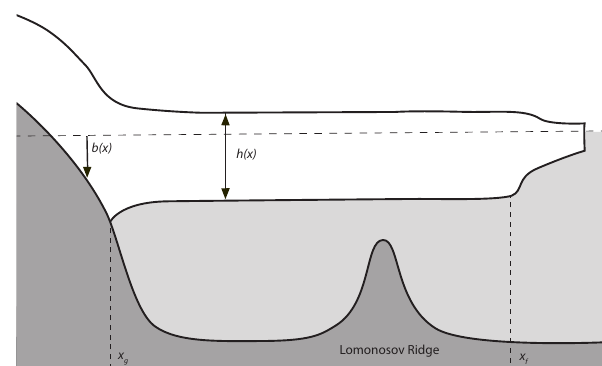
Figure 3. The geometry of the one-dimensional Arctic ice-sheet– ice-shelf model, illustrated in a case without grounding on the Lomonosov Ridge. Here, h(x , t) denotes the ice thickness and b(x) the bed elevation, counted positive below the sea level. The ice shelf has it continental grounding line at x g and is dammed towards the Fram Strait entrance, located at x f , which divides the interior and exit regions of the ice shelf. The x – z transect shown here cor- responds to central x transect indicated in Fig. 2. In the interior ice- shelf region h is essentially constant. Near the continental ground- ing line ( x g ), however, there is a narrow transition zone where the ice thickness increases away from the grounding line; see Eq. (13) and Fig.